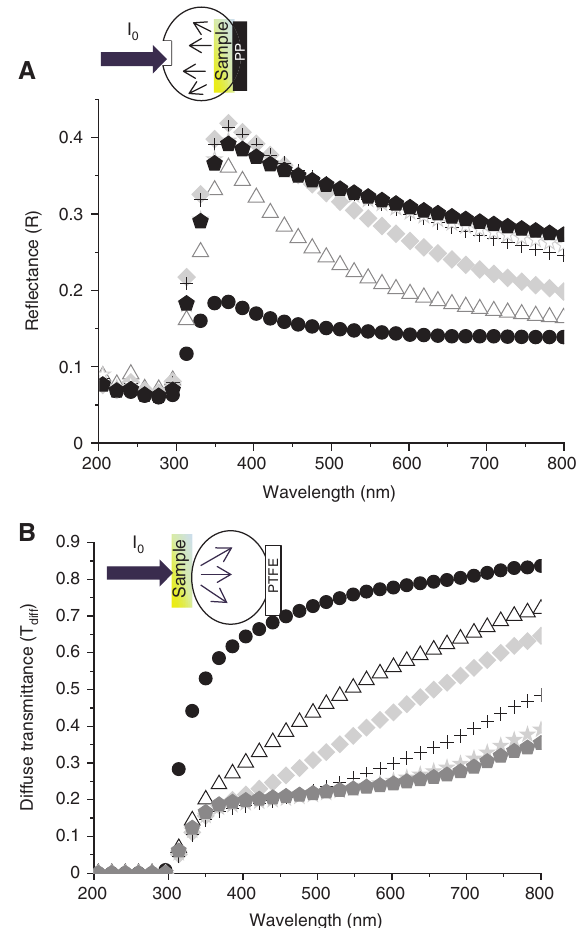
Figure 4 Diffuse reflectance (A) and diffuse transmittance (B) spectra of a series of acrylate miniemulsions containing PI-1 , and displaying different average droplet diameters. � 50 nm, ∆ 70 nm, 115 nm, + 165 nm, 210 nm, and 300